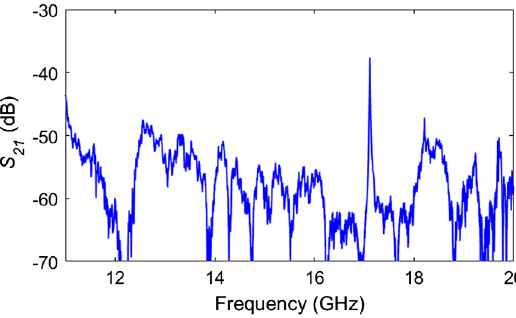
FIG. 16. The magnitude of S 21 of the HPBG cell.